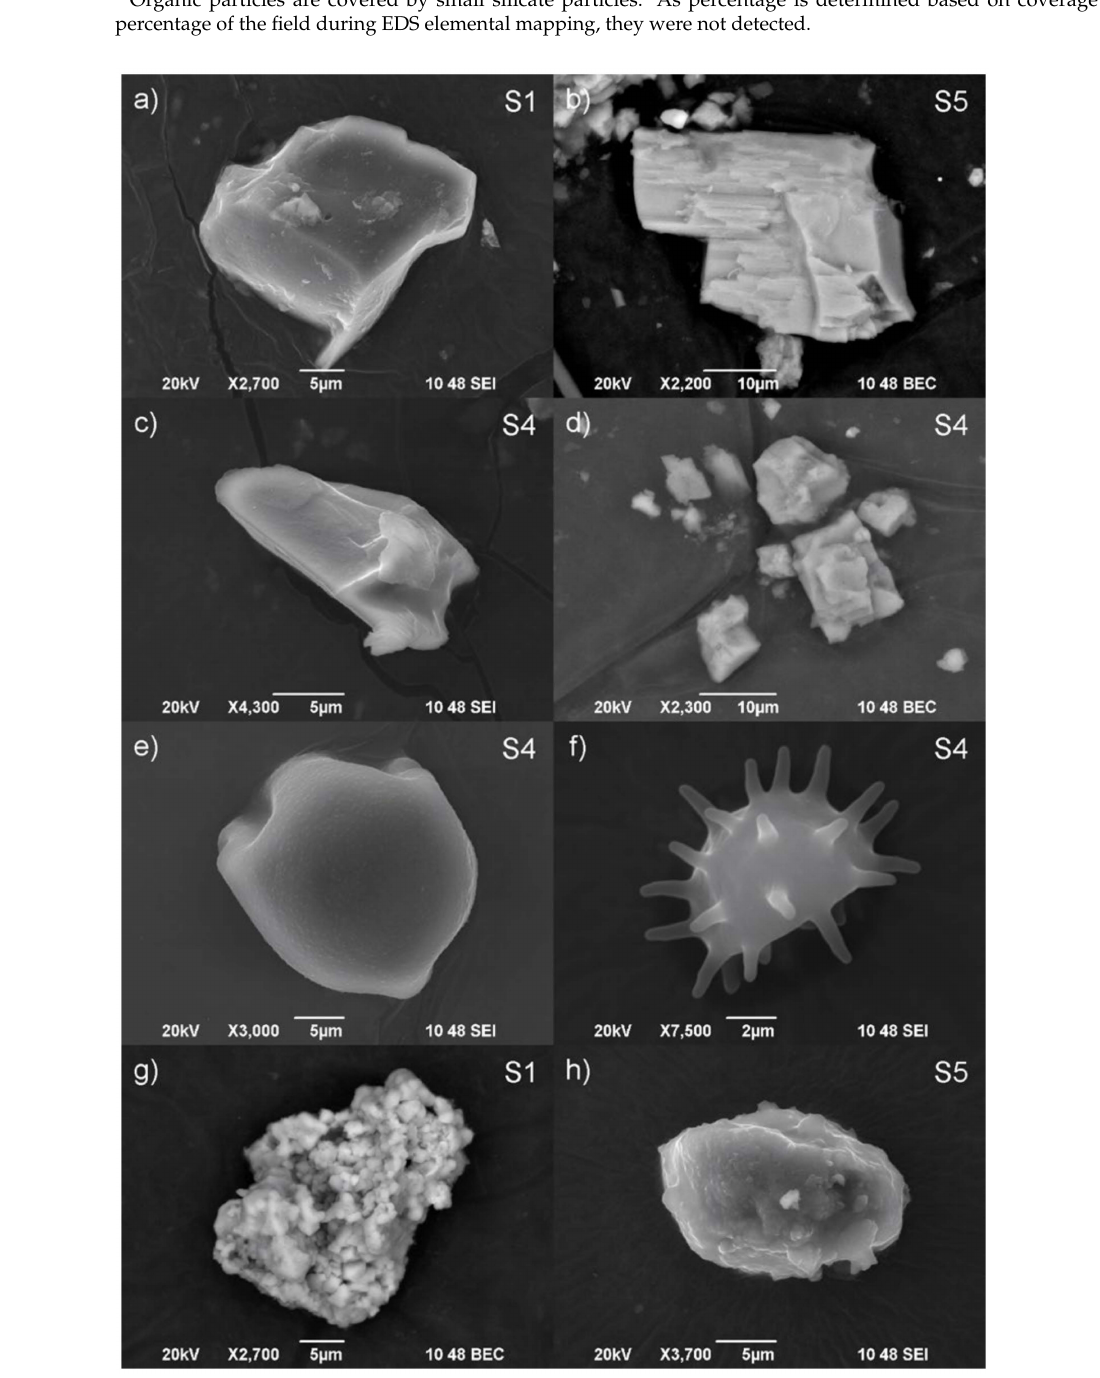
Figure 5. Particles from passive deposition samples. Presented images are taken in SEI or BSE modes as indicated in the lower right corner of images. The sample code is marked in the upper right corner of each figure. ( a ) angular Si-O (quartz); ( b ) angular Si-Al-Ca-Mg-O particle (aluminosilicate); ( c ) and ( d ) Ca-Mg-C-O (dolomite); ( e ) and ( f ) organic particles, spores; ( g ) irregularly shaped Fe-Cr-O agglomerate; ( h ) Na-Cl (salt). Some spectra are provided in Supplementary Figure